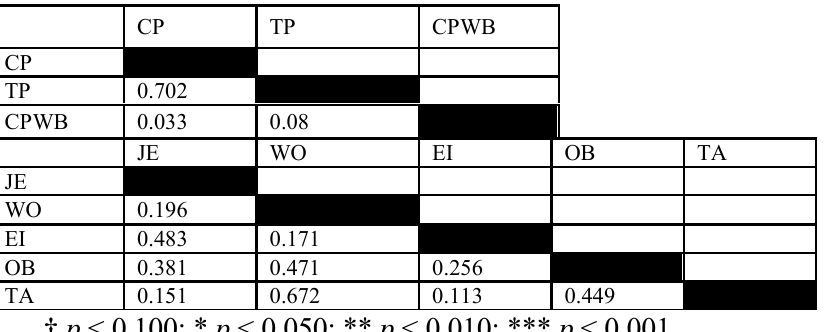
Table 4. Heterotrait-Monotrait (HTMT)